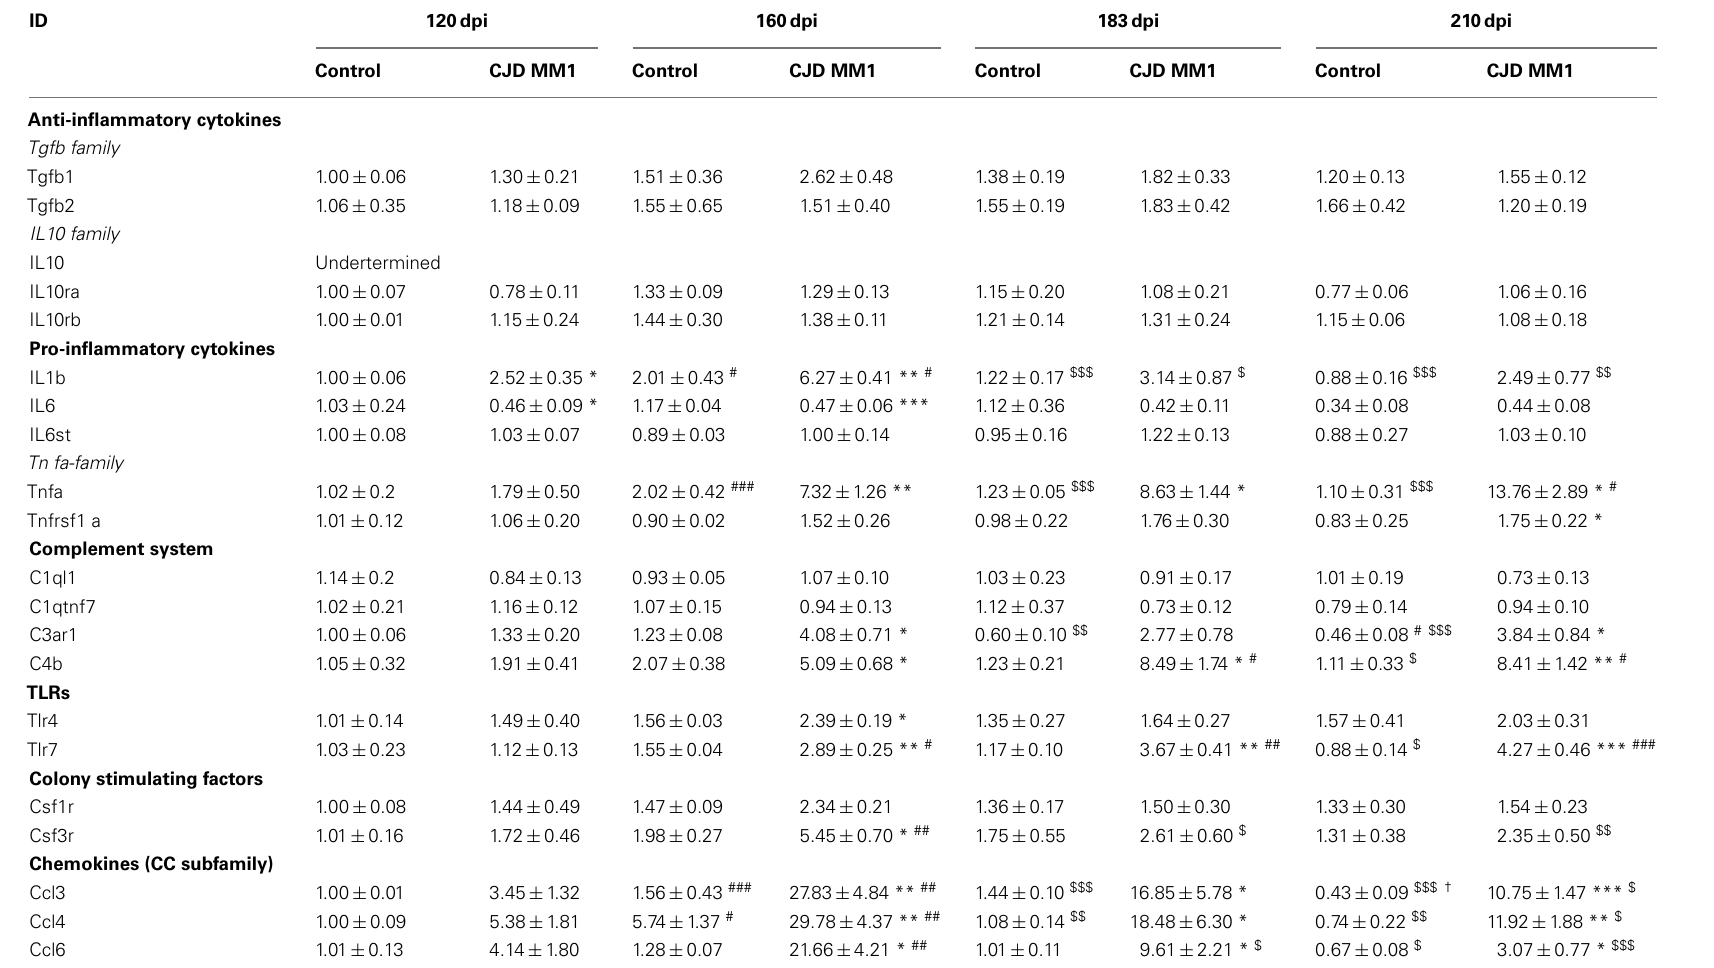
Data are represented as the mean SEM. *p < 0.05, **p < 0.01, ***p < 0.001 sCJD MM1 compared with control cases at the same dpi. # p < 0.05, ## p < 0.01, ### p < 0.001 compared with inoculated animals at the stage of 120dpi; $ p < 0.05, $$ p < 0.01, $$$ p < 0.001 compared with inoculated animals at the stage of 160dpi; † p < 0.05 compared with inoculated animals at the stage of 183dpi (Tukey’s post hoc